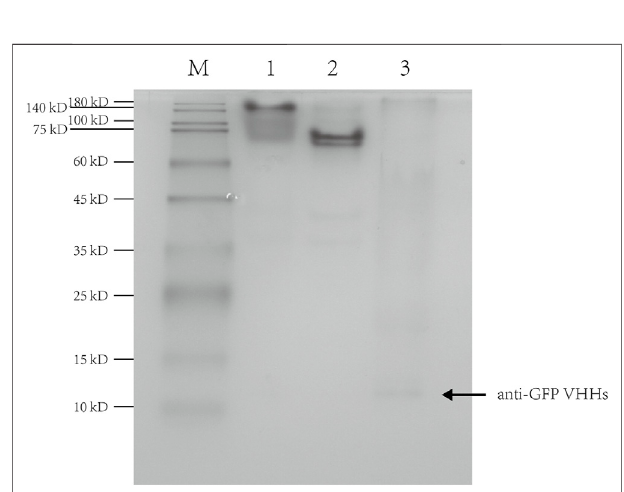
FIGURE5| Native-PAGEoftheinteractionbetweenanti-GFPVHHsand ELP30-GFP. Lane 1: the mixture of anti-GFP VHHs and ELP30-GFP; lane 2: ELP30-GFP alone; lane 3: anti-GFP VHHs alone. M: Enhanced 3-color Regular Range SMOBIO Protein Marker (PA2511) (10.0 – 180 kDa) purchased from